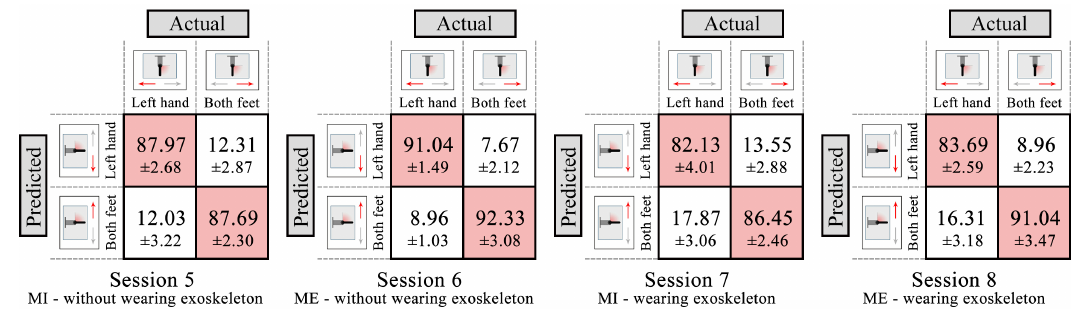
Figure 7. Confusion matrices (in %) for four sessions in the online-control phase, averaged across all subjects. The numbers of each entry in the matrix represent the mean value and standard deviation across all subjects. The main diagonal entries stand for the correct classification, and the off-diagonal entries stand for the